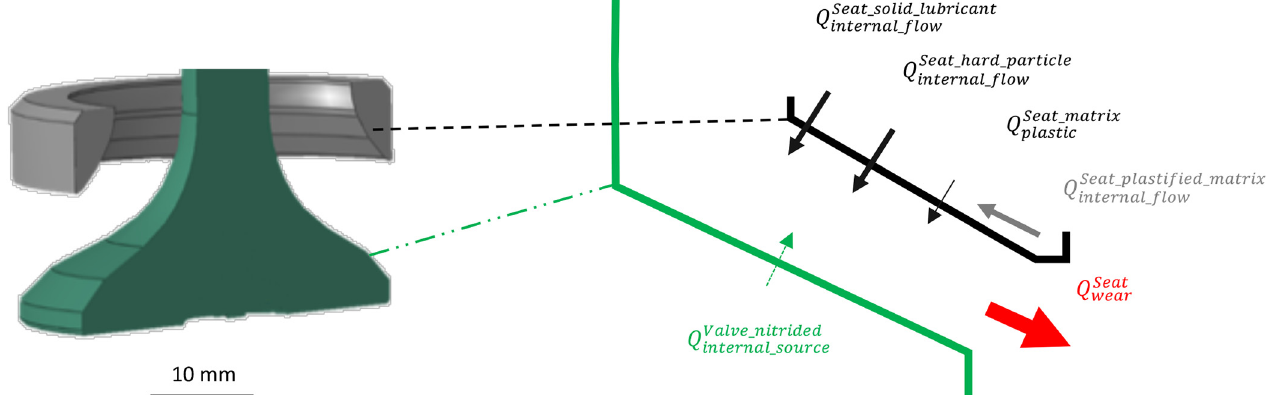
Fig. 19. Summary of fl ows from 1 st bodies.